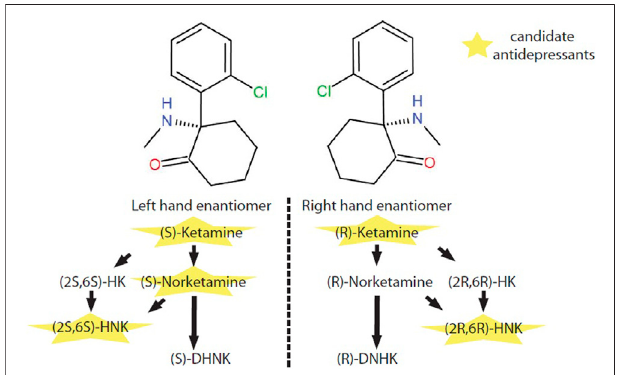
FIGURE 1 | Metabolic pathway of ketamine enantiomers. (S)-ketamine and ( R )-ketamine are a pair of stereoisomers. In vivo , ( S )-ketamine and ( R )- ketamine is initially demethylated to ( S )-norketamine or ( R )-norketamine. ( S )- norketamine or ( R )-norketamine is further metabolized to ( S )-DHNK or ( R )-DHNK. ( S )-norketamine or ( R )-norketamine can also be hydroxylated into ( 2S,6S )-HNK or ( 2R,6R )-HNK, respectively. Recently, ketamine and several of its metabolites with potential antidepressant-like effects have intrigued enthusiastic investigations at preclinical and clinical levels. Abbreviations: ( 2R , 6R )-HK, ( 2R , 6R )-hydroxyketamine; ( 2S , 6S )-HK, ( 2S , 6S )- hydroxyketamine; ( 2R , 6R )-HNK, ( 2R , 6R )-hydroxynorketamine; ( 2S , 6S )-HNK, ( 2S , 6S )-hydroxynorketamine; ( R )-DHNK, ( R )-dehydronorketamine; ( S )- DHNK, ( S